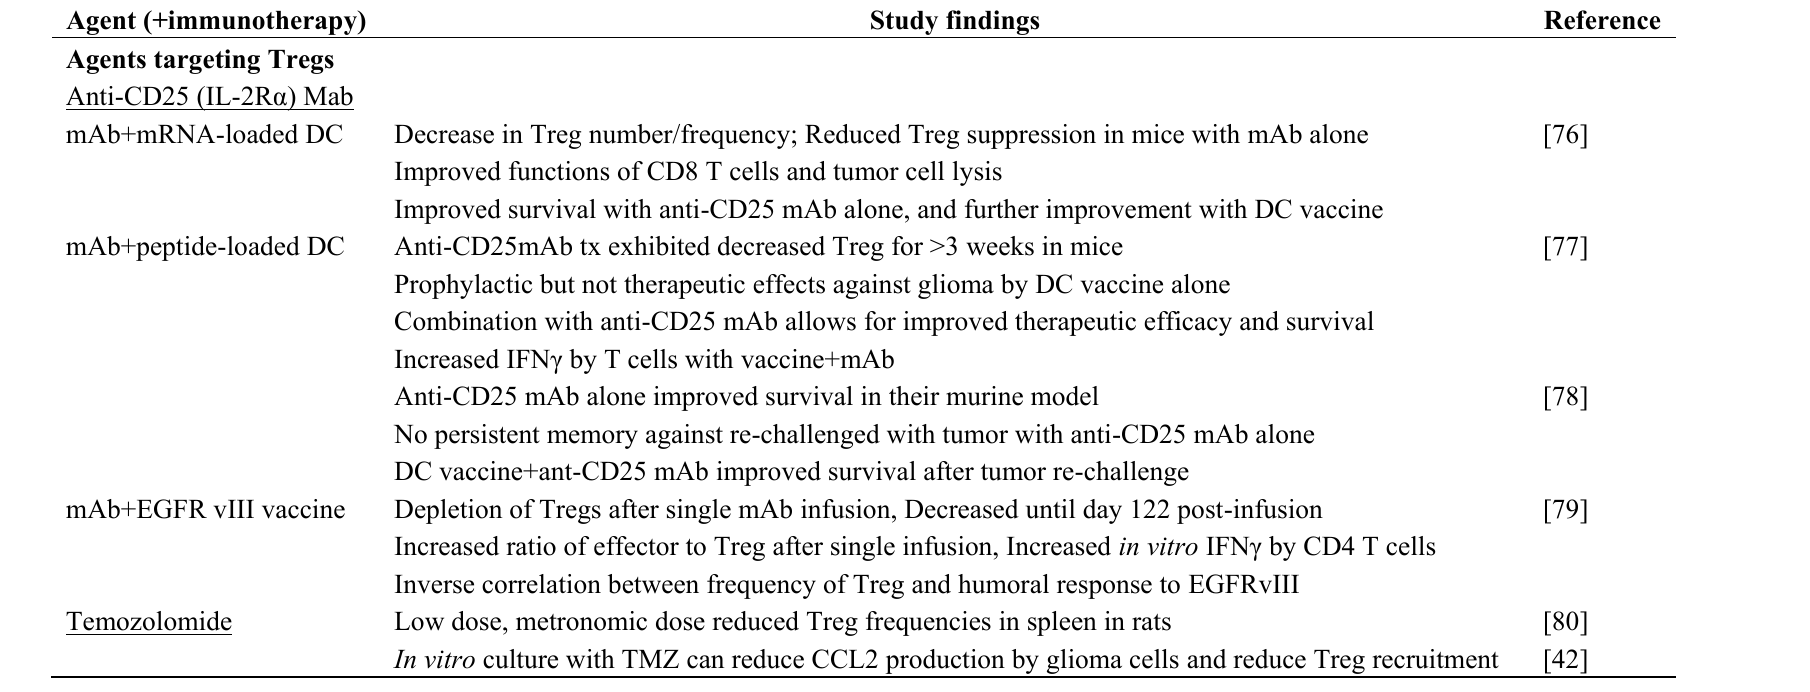
Table 1. Agents targeting immunosuppressive